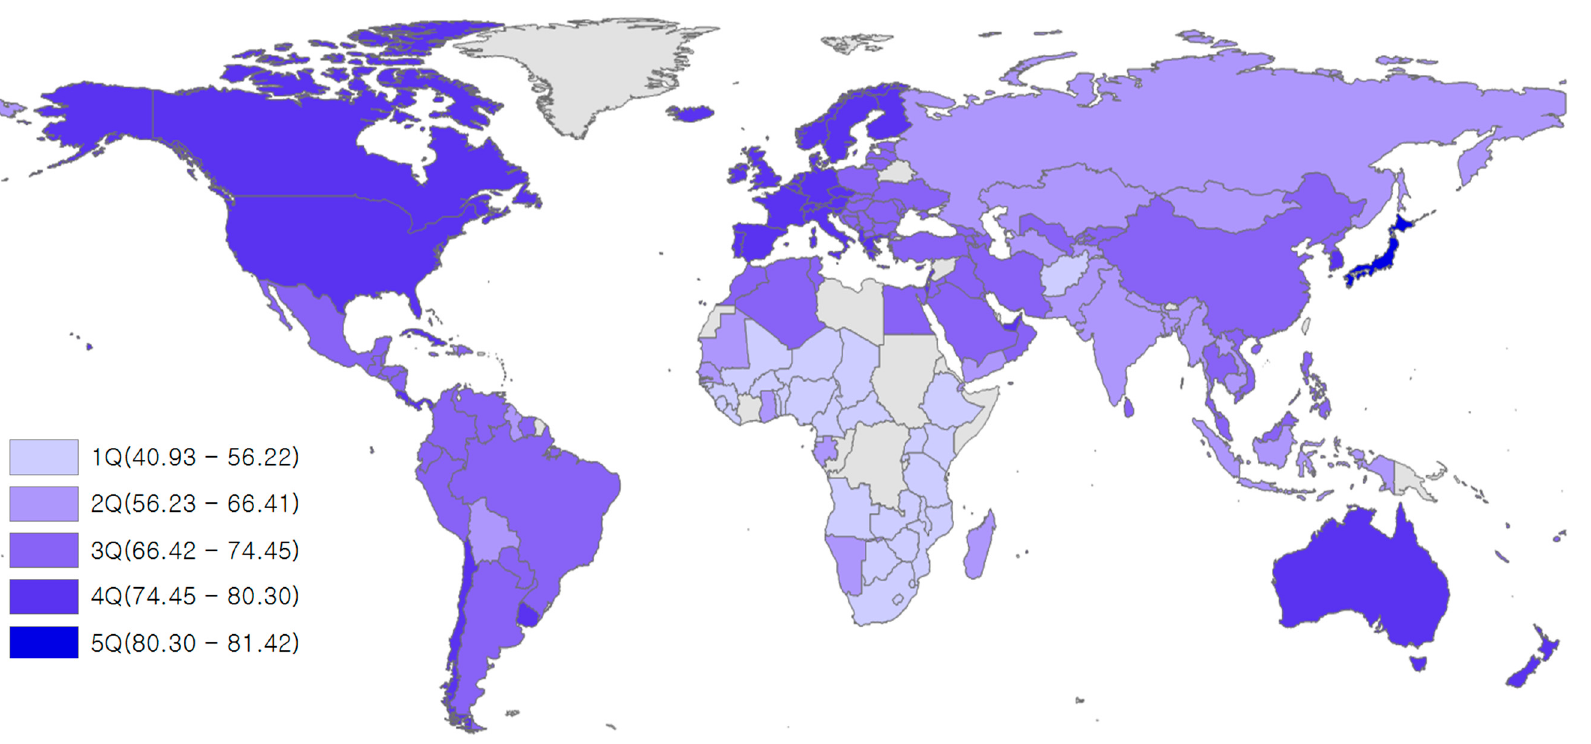
Figure 2. Mean life expectancy (in years) for 164 countries over the period 1992–2013.